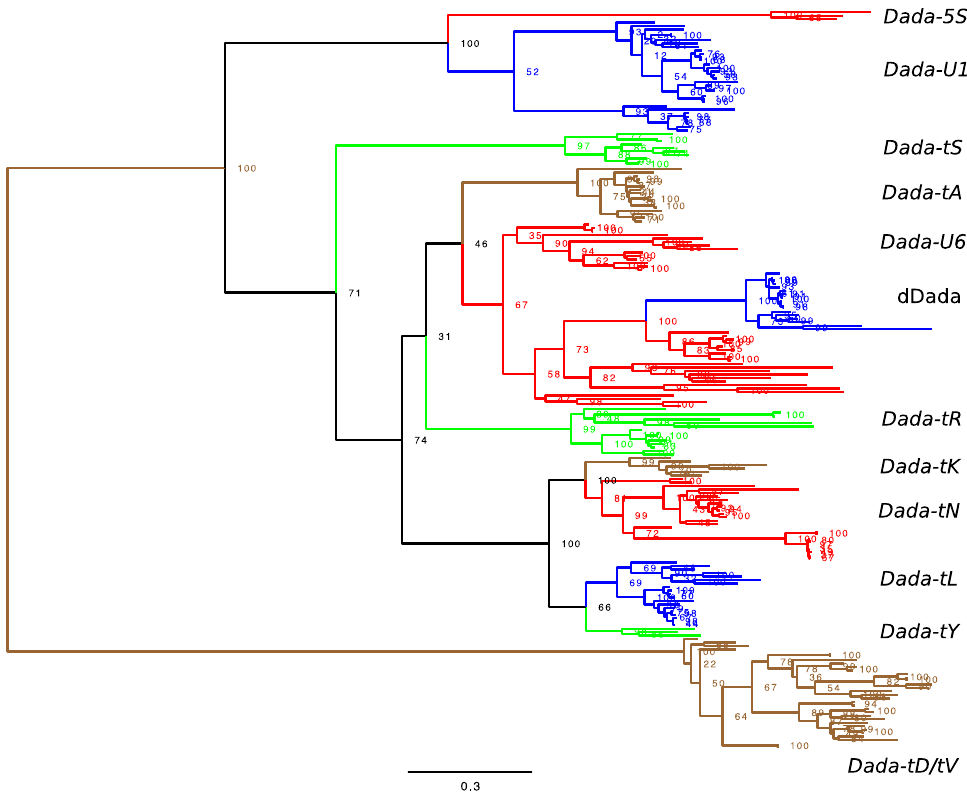
Figure 2. Phylogenetic tree of Dada transposases. Monophyletic or paraphyletic Dada lineages are colored based on the characterized target sequences. Dada-tD and Dada-tV are not well separated and thus shown as Dada-tD / tV . The complete phylogenetic tree with leaf names is available in Figure S3. The second branch is composed of Dada-U1 and Dada-5S . Two Dada-U1 families